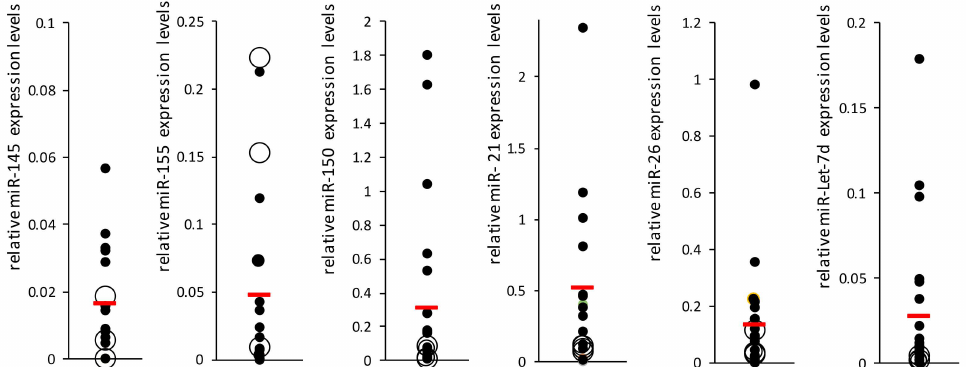
Figure 2. Mean miRNA levels in the SSc-noPAH group. miRNA levels in the plasma of 25 SSc-noPAH patients were evaluated using qRT-PCR. miR-16 served for normalization. Patients underwent echocardiography before blood sampling and at the end of the study. miRNA values of the patients with stable echo results during this time are marked in full black dots ( n = 21). The miRNA levels of patients whose echo levels increased during this period are marked by empty circles ( n = 4). All y-axis values are presented relative to miR-16. The red line indicates the mean value of each group. SSc patients undergo routine monitoring to evaluate their condition every few